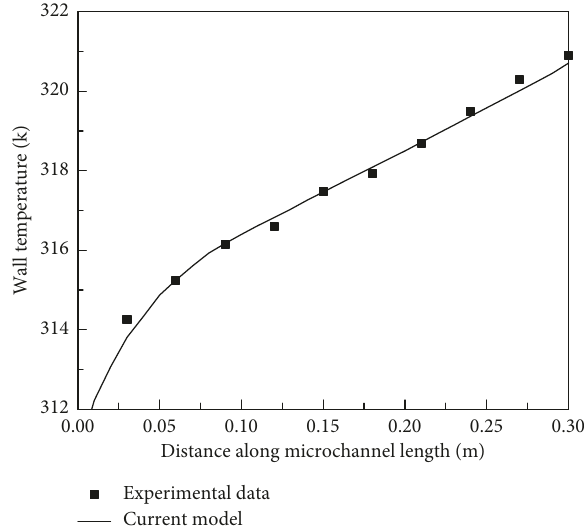
Figure 3: Validation of the computational model against experi- mental data